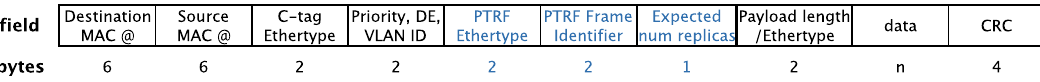
Figure 10. Format of an IEEE 802.1Q Ethernet Data frame that has been replicated using PTRF. As we can see highlighted in blue, the frame conveys new fields, namely the PTRF Ethertype, PTRF frame identifier and the expected number of